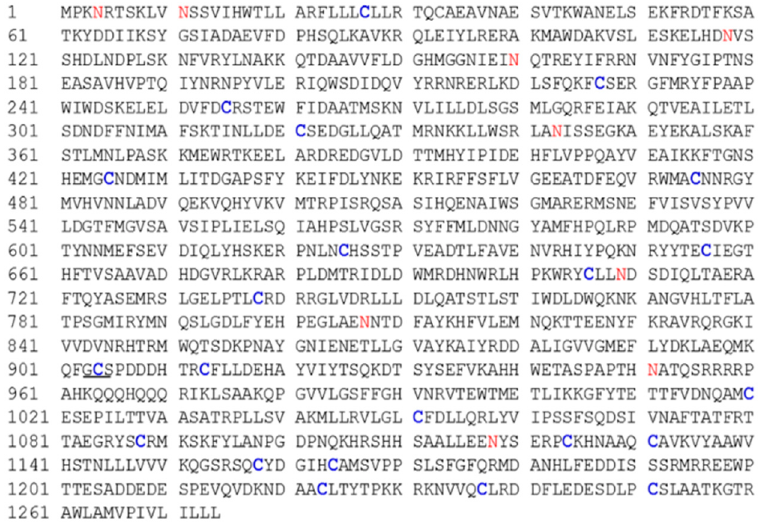
Figure 2. Amino acid sequence of the DdCa v α 2 δ subunit. Blue indicates cysteine residues, red indicates N-glycosylation sites, and underlining indicates suspected GPI anchor sites.